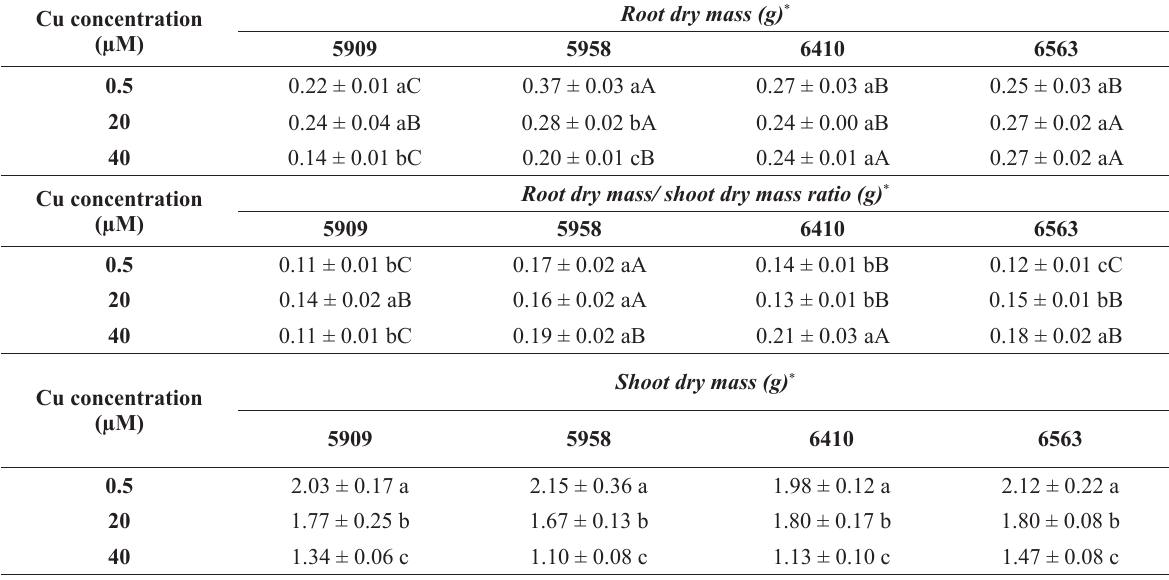
Values from two plants. * Values represent the means ± standard deviation of four repetitions. Capital letters indicate comparison between cultivars in the same Cu concentration, whereas lowercase letters indicate a comparison between Cu concentrations in the same cultivar (p